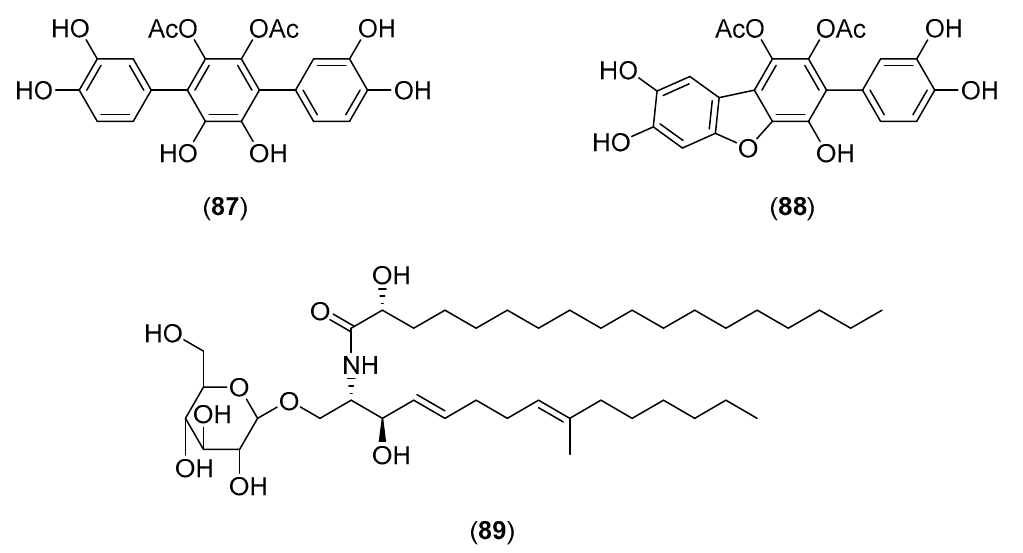
Figure 17. Chemical structures of selected compounds isolated from Sarcodon imbricatus.